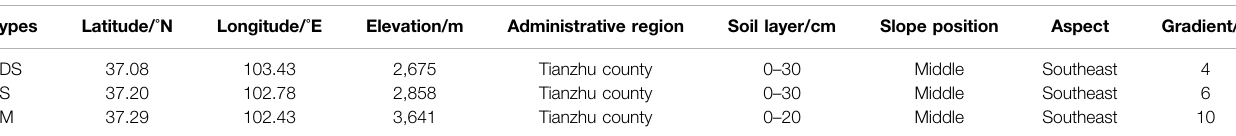
TABLE 1 | Site information under three vegetation